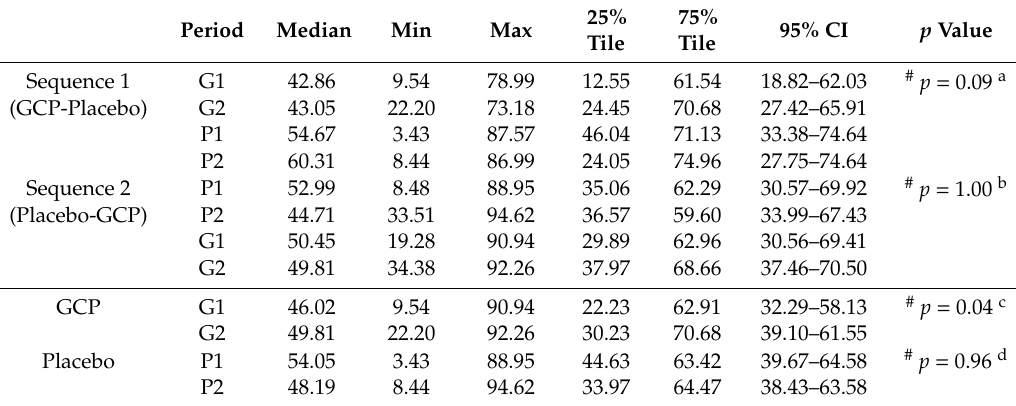
Table 4. VAS values for a question “How is the dryness of your mouth?”